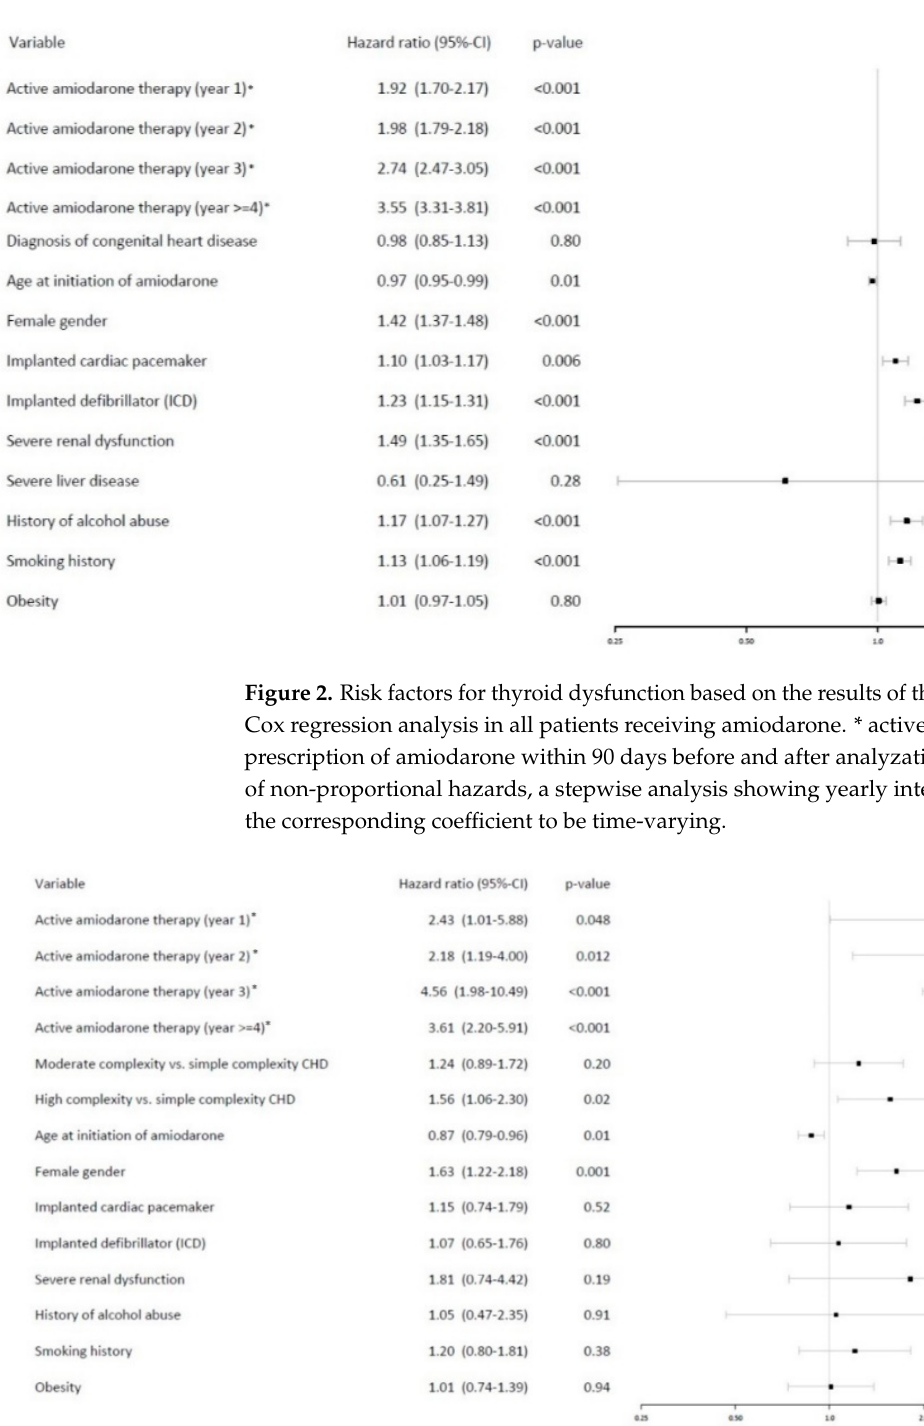
Figure 3. Risk factors for thyroid dysfunction based on the results of the multivariate time-dependent Cox regression analysis specifically in adult patients with congenital heart disease (ACHD) receiving amiodarone. * active amiodarone intake defined as prescription of amiodarone within 90 days before and after analyzation time. To avoid the problem of non-proportional hazards, a stepwise analysis showing yearly intervals was used, thus allowing the corresponding coefficient to be